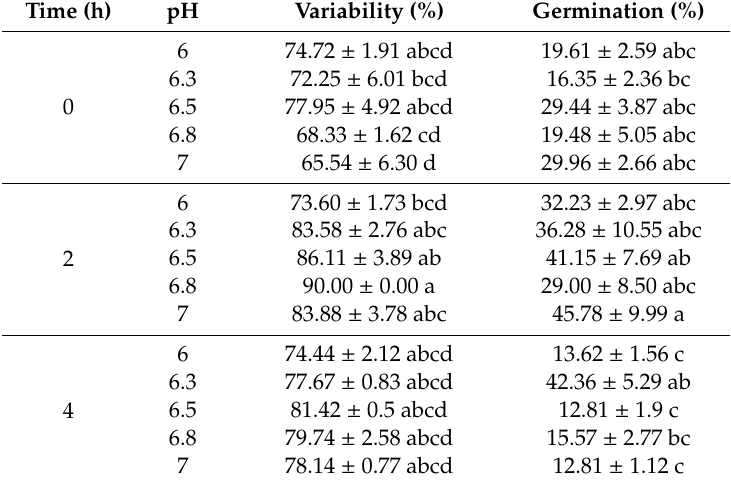
Table 3. E ff ect of pH on the viability and germination of pollen, dehydrated for 0 h (a), 2 h (b), and 4 h (c). Time (h) pH Variability